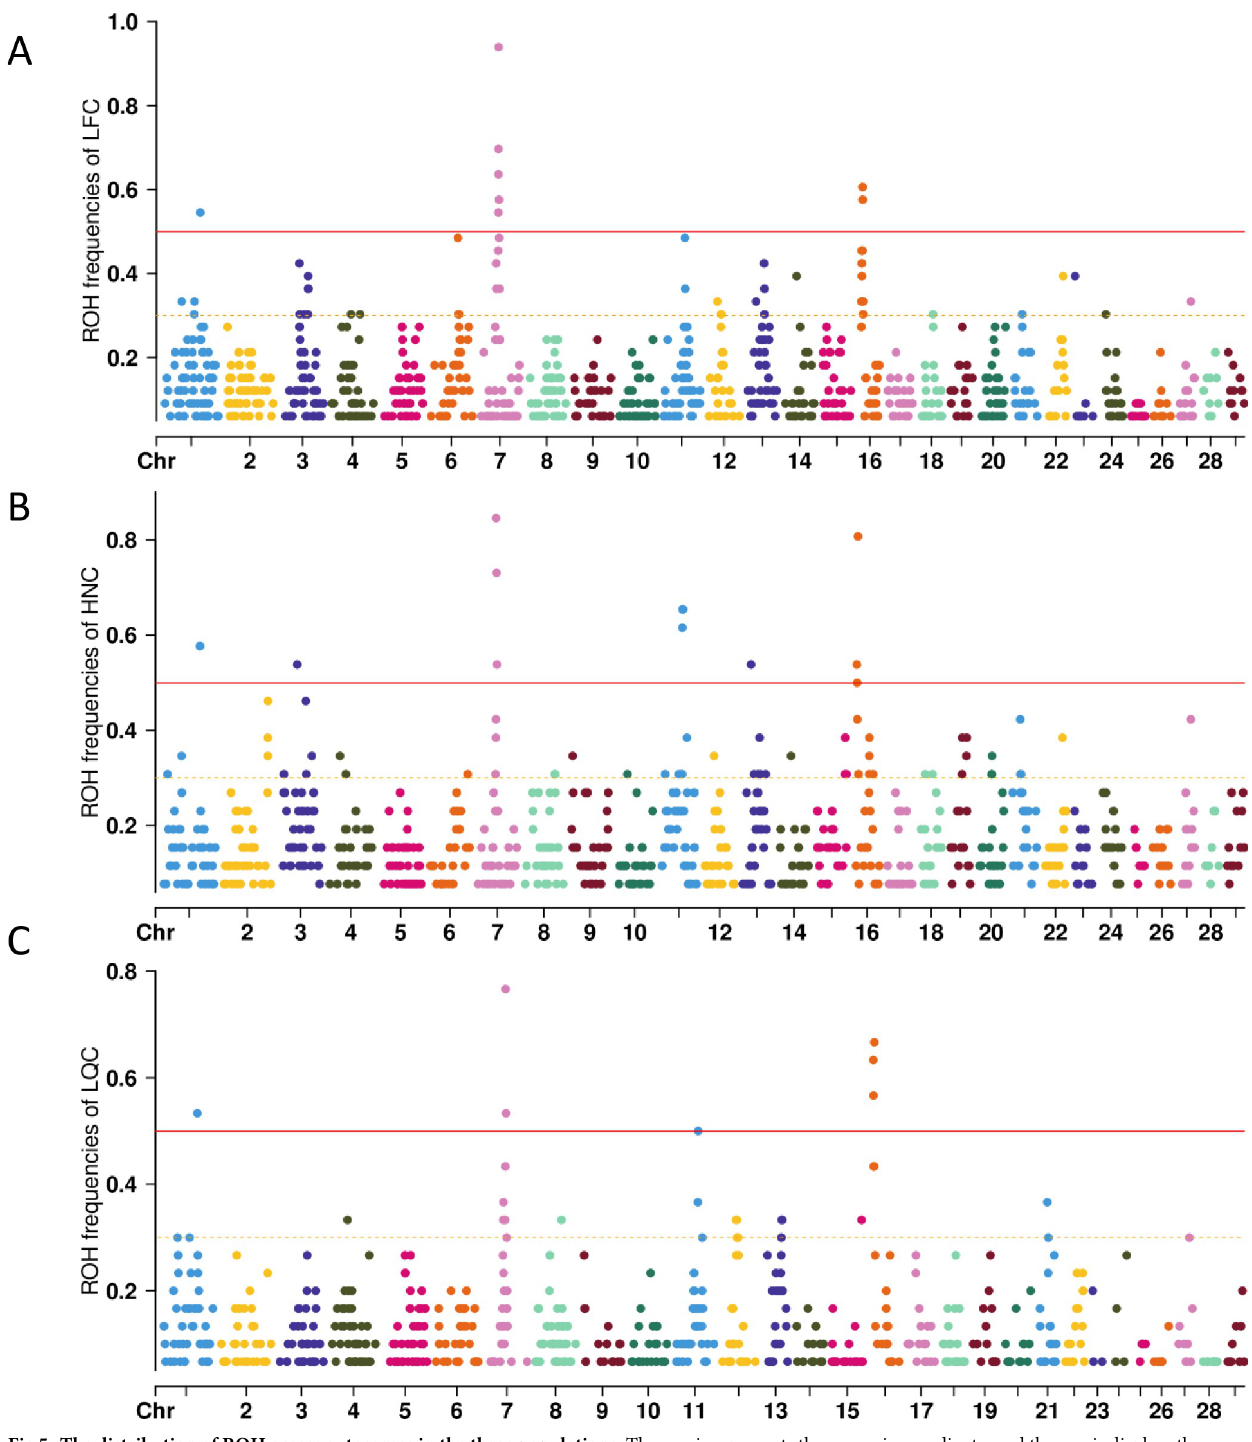
Fig 5. The distribution of ROH across autosomes in the three populations. The x-axis represents the genomic coordinate, and the y-axis displays the frequency of overlapping ROH among individuals. (A) LFC; (B) HNC; (C) LQC.